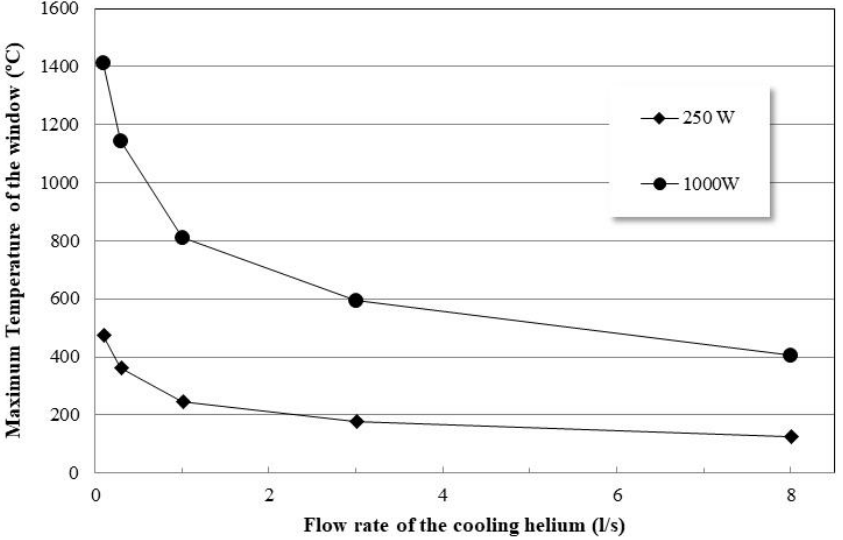
Figure 20. Maximum temperatures of the target window as a function of the flow rate of the cooling helium, for two distinct powers of 250 and 1000 W.